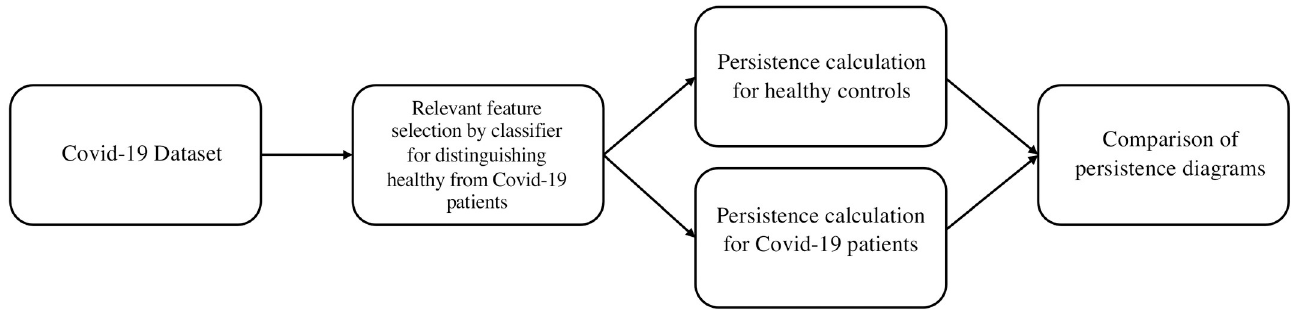
Fig 3. Flowchart of computation pipeline. The pipeline includes three main stages, namely, (i) relevant feature selection, (ii) persistence computation, and (iii) comparison of persistence diagrams.